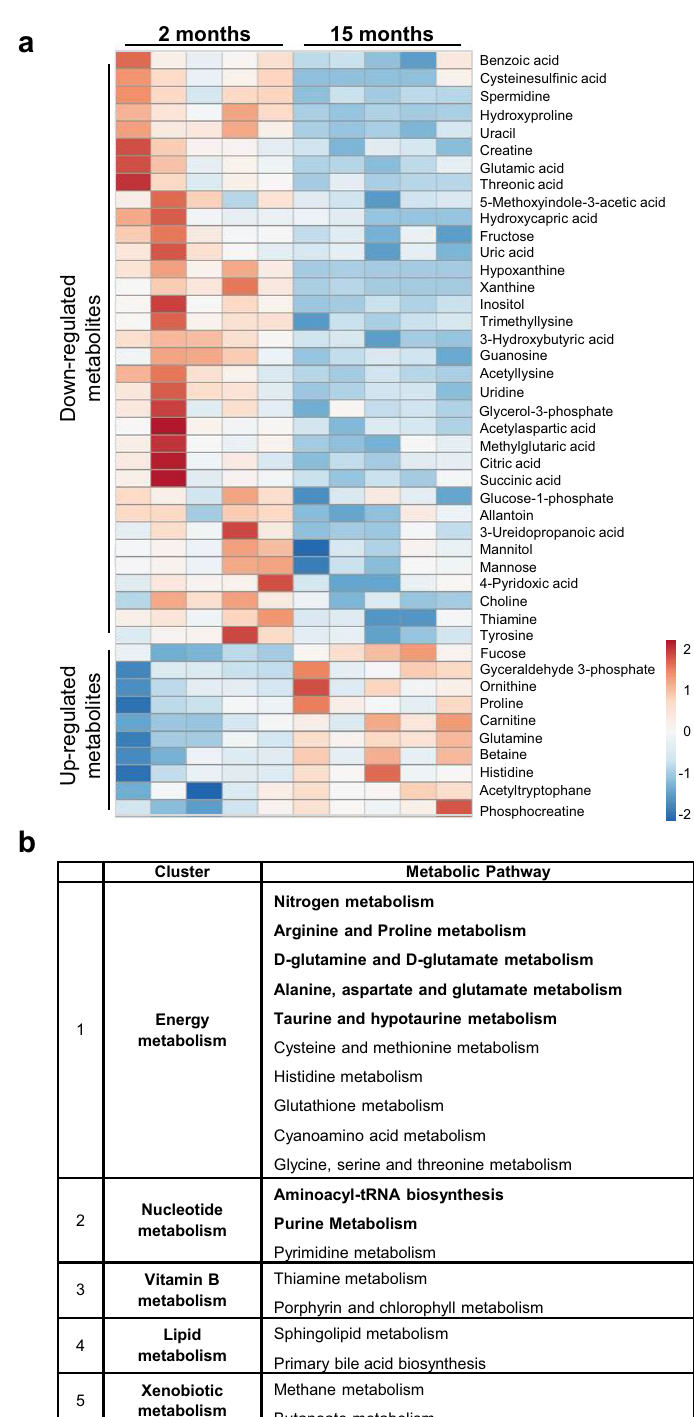
Figure 2. Age-related changes in plasma metabolites reflect effects on purine metabolism in aged BAT. ( a ) Heatmap depicting plasma metabolite concentrations comparing plasma samples from young (2 months) to aged (15 months) mice that are significantly (p < 0.05) different between both age groups (n = 5 / group). All metabolites were detected by LC–MS and GC–MS metabolomic analysis. ( b ) Pathway identification analysis for polar and non-polar plasma metabolites with age-related changes using MetaboAnalyst software. Metabolites were selected based on significant (p < 0.05) differences between age groups. Tabular summary of all pathways identified from plasma metabolites, including pathways with significant enrichment (bold; p < 0.05), which were subsequently grouped into functionally related sub-clusters, i.e. (1) nutrient/ energy metabolism, (2) nucleotide metabolism, (3) vitamin metabolism, (4) lipid metabolism and (5) xenobiotic